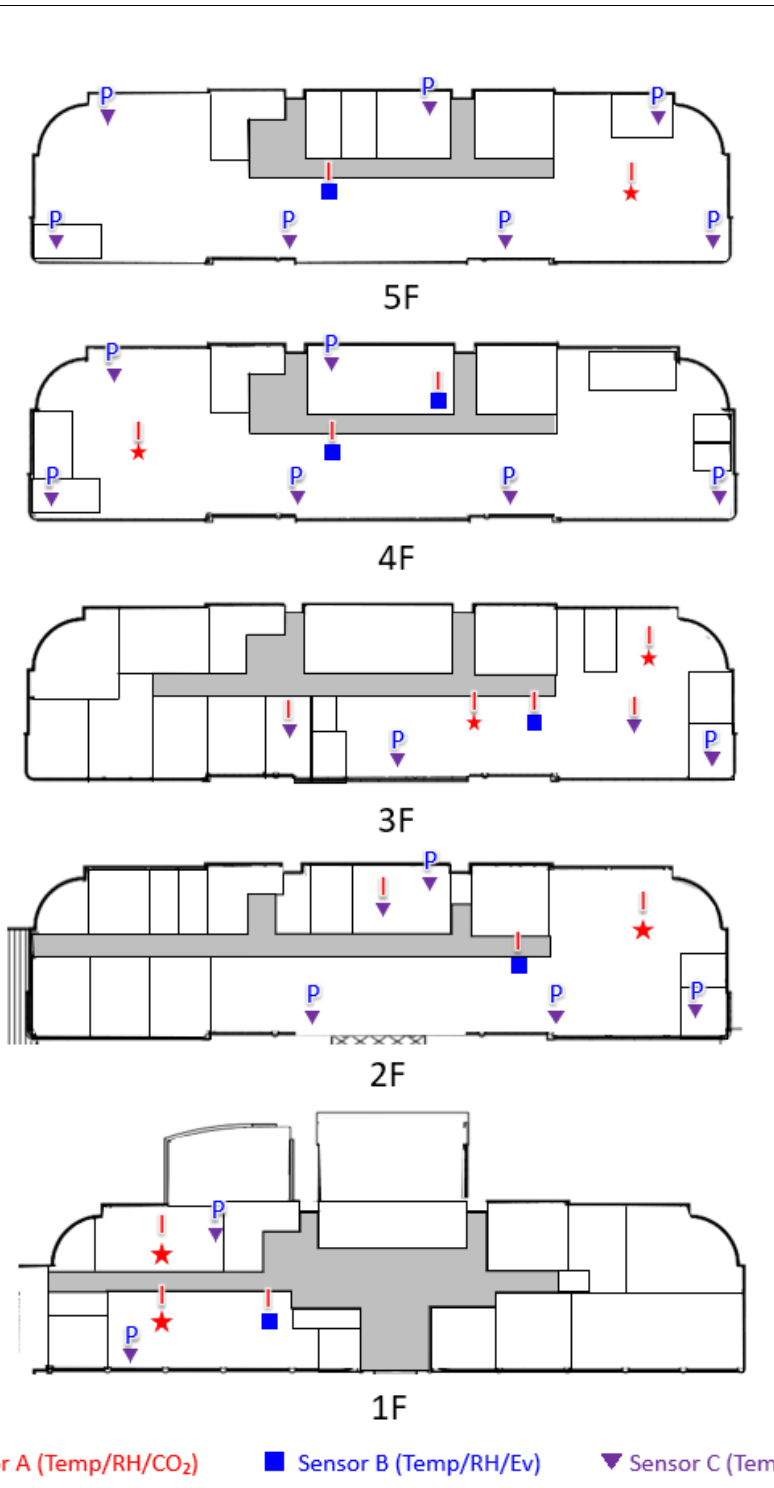
Figure 4. Sectional layout of each floor of the research institute. For security reasons, the floor plan is presented in limited details. The symbol P stands for the period zone, and the symbol I stands for the interior zone. Sensors A, B, and C are the same as those shown in Figure 3.